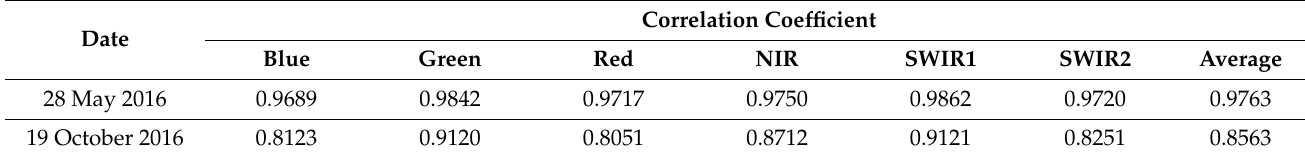
Table 5. Comparison of original Landsat imagery on the base date and predicted date.